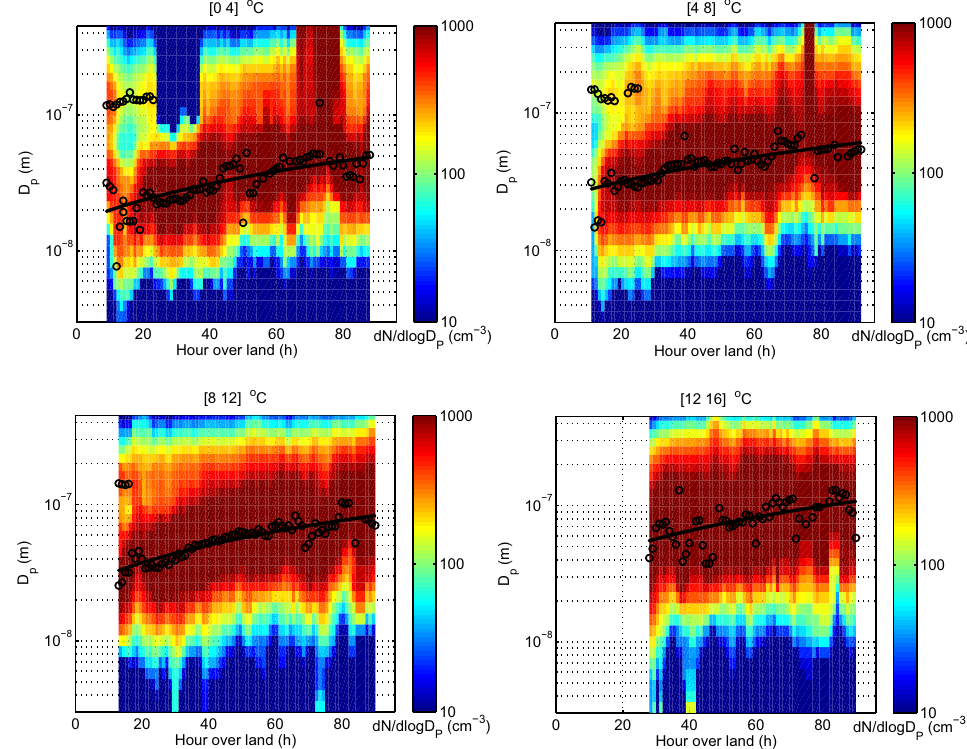
Figure 5. Aerosol particle-size distributions as a function of hour over land in the first four temperature bins at the SMEAR I station, Värriö. The black circles are the maxima of the normal size distribution function at each hour, and black line depicts the mode